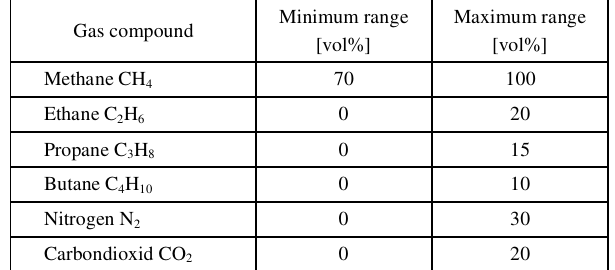
Table 2. Selected gas species and relevant measurement